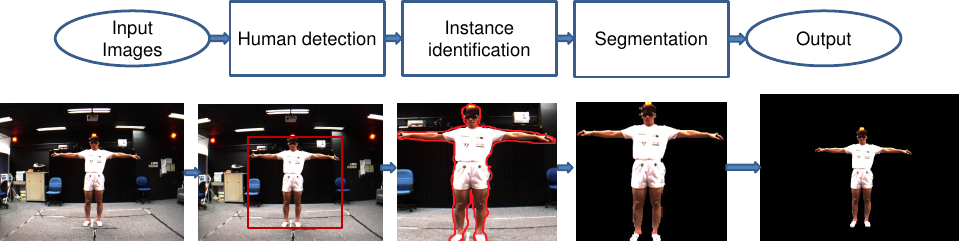
Figure 2. An explanation of object detection and semantic and instance segmentation [30].